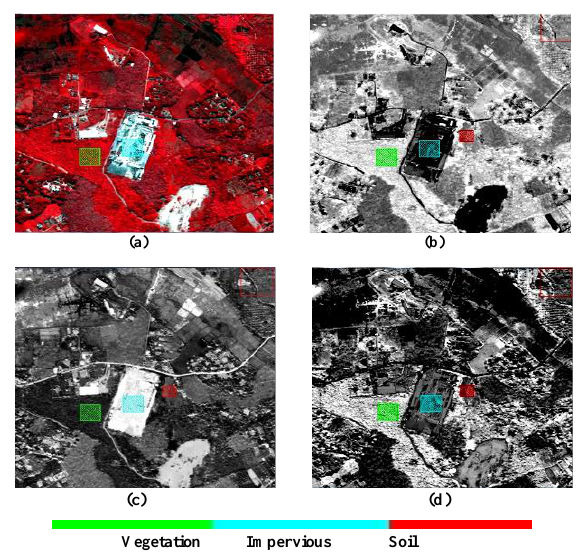
Fig.2. (a) Worldview-II false colour multispectral band composite RGB (6, 5, 4) with ground samples, (b), (c) and (d) fractional images generated by SAM, for V-I-S